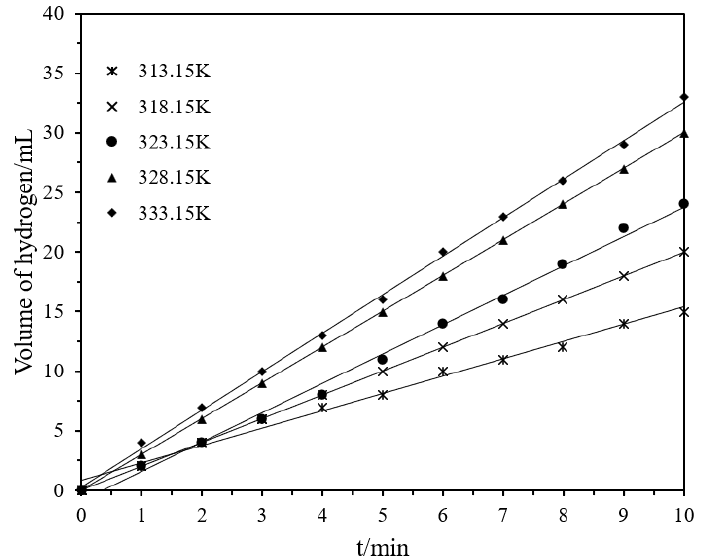
Figure 6. Volume of hydrogen versus time plots for the catalytic hydrolysis of DMAB by Ni/Pd nanoclusters (Ni/Pd = 20/1) (1.0 g) with different temperatures varying from 313.15 to 333.15 K. According to Figure 7, the activation energy E a , enthalpy Δ H, and entropy Δ S of the hydrogen production were estimated to be 34.95 kJ•mol −1 , 32.26 kJ•mol −1 , and −138.64 J•mol −1 K −1 , respectively, by using Equations (5) and (6). The negative activation entropy indicates that the total number of molecules was reduced in the rate-determining step of the elementary reaction, and that the hydrolysis reaction proceeded via an associative mechanism in which the participation of the water molecule in the rate-determining step may involve its attack on the DMAB substrate.